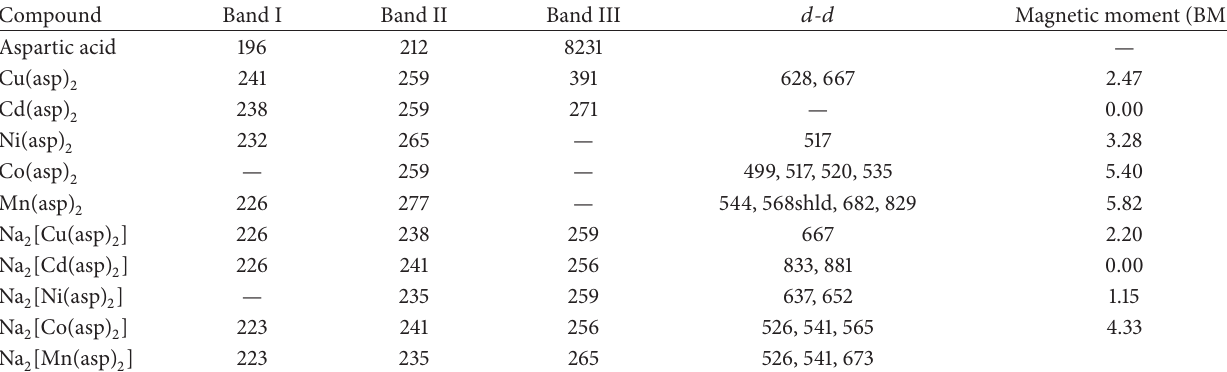
Table 2: Electronic spectra bands, for the